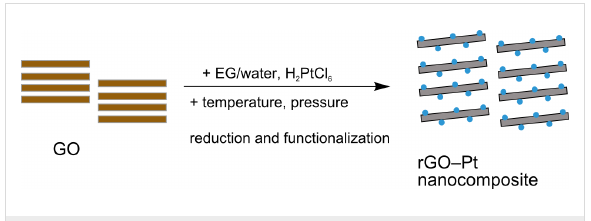
Figure 5: Simultaneous reduction and functionalization of GO to rGO–Pt nanocomposite.